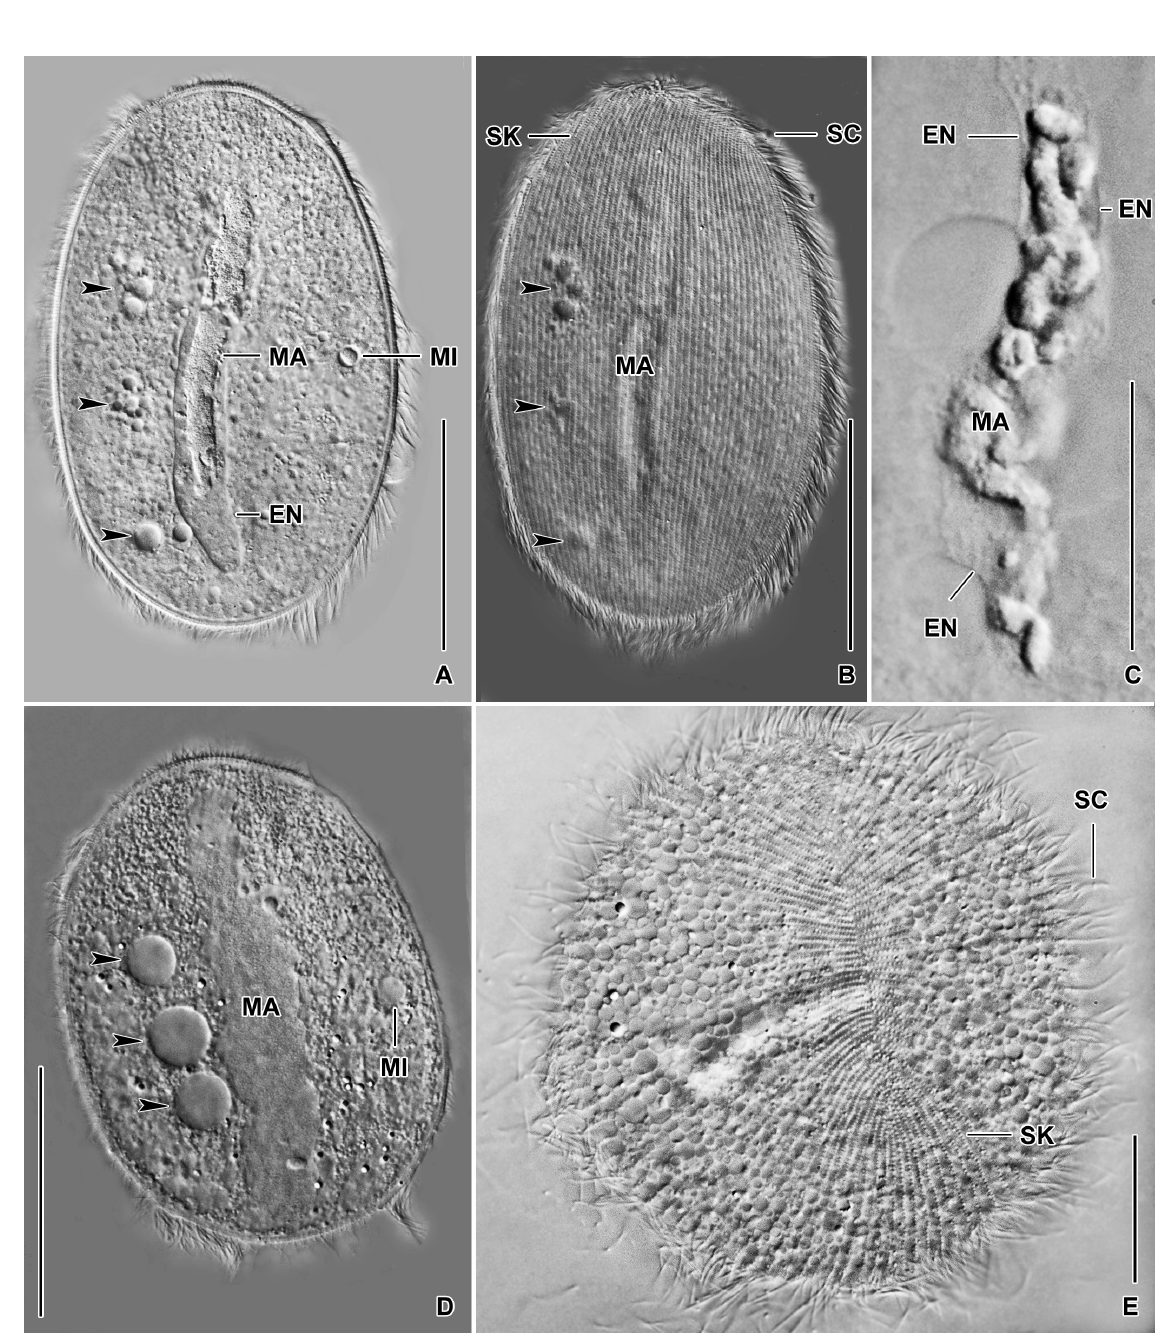
Fig. 9. Anoplophrya lumbrici (Schrank, 1803), Slovak specimens in vivo . A, D . Optical sections, showing the general body organization. The body is elliptical with both ends rounded. The macronucleus is rod- like and extends through the cell’s midline. The micronucleus is situated conspicuously far away from the macronucleus, namely, near the middle of the left body margin and always opposite to the row of contractile vacuoles (arrowheads). B . Ventral view, showing the somatic ciliary pattern. Arrowheads denote the contractile vacuoles which originate by fusion of three to five vesicules. C . In dying cells, the macronucleus diminishes in size leaving behind a conspicuous hyaline envelope. The macronucleus sometimes also fragments within the envelope in postmortem cells. E . Frontal view, showing the apical suture. Scale bars: A–B, D = 50 µm; C, E = 20